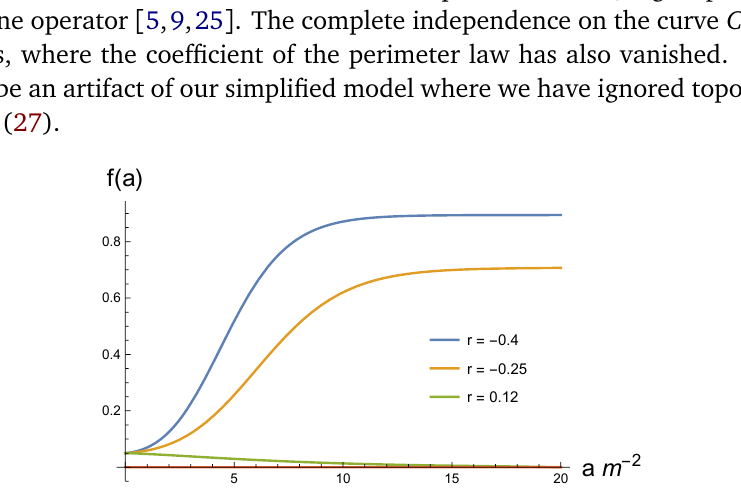
Figure 4: Some examples of different profiles of the string field as a function of the area in the condensed and uncondensed phase for different values of rm −